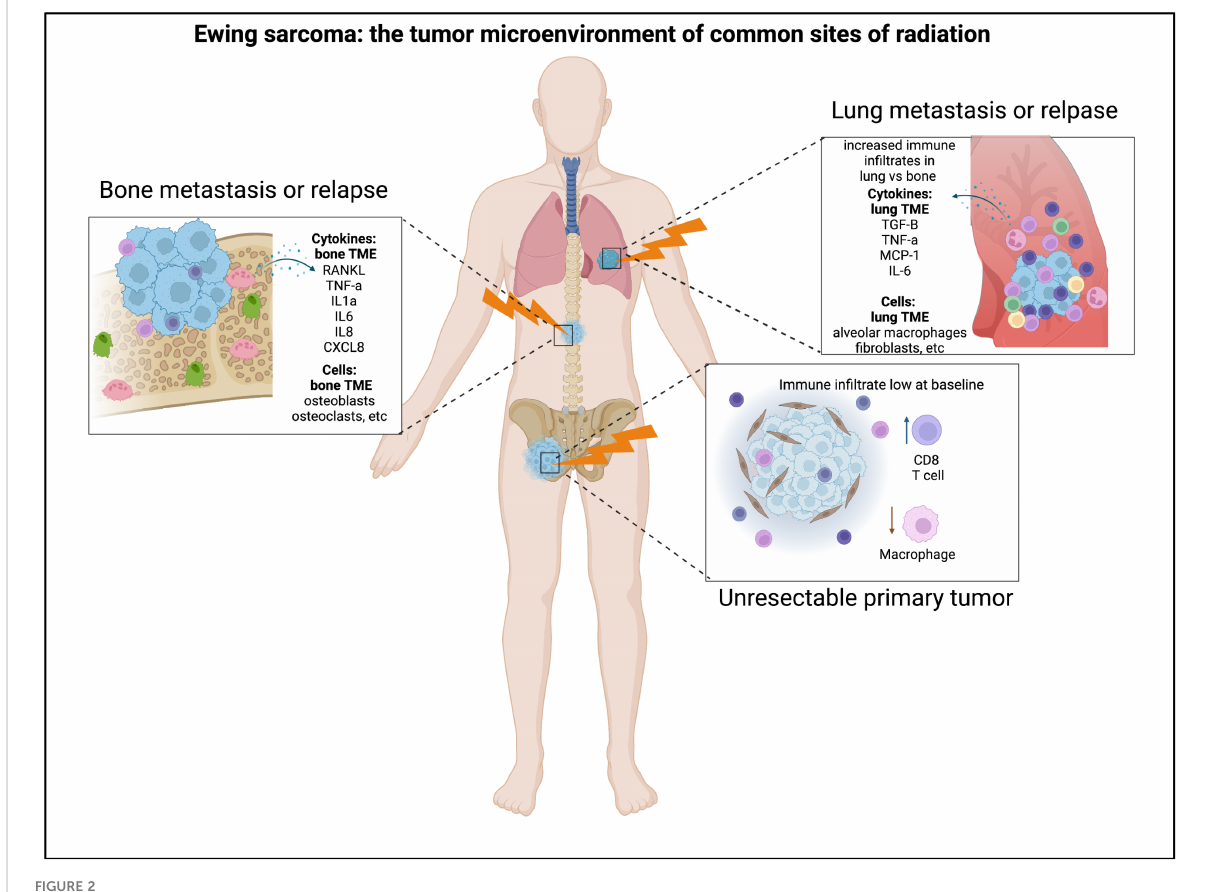
FIGURE 2 Radiation and the Ewing sarcoma tumor immune microenvironment. Radiation is often utilized for the treatment of Ewing sarcoma in the setting of unresectable primary tumors, lung metastases, relapse to the bone, etc. The Ewing tumor immune microenvironment can demonstrate differences in immune in fi ltration and cytokine abundance in these distinct microenvironments where radiation is utilized. Figure created by